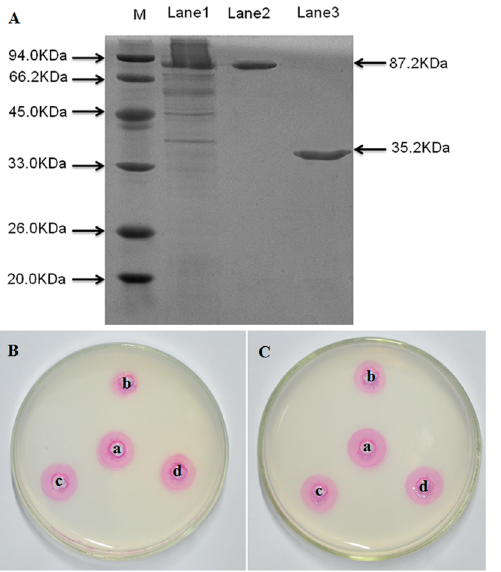
Fig 5. Purification and characterization of recombinant CkPGIP1. A. Lane 1, total protein extract from E . coli expressing recombinant CkPGIP1; Lane 2, flow through from a Ni-IDA superflow column; Lane 3, purified CkPGIP1, with fusion tags removed. B-C. Agarose diffusion assay of Botrytis cinerea ( B ) and Rhizoctonia solani polygalacturonase ( C ) in the presence or absence of purified recombinant CkPGIP1. a, 25 μ L enzyme; b, 25 μ L enzyme + 15 μ g CkPGIP1; c, 25 μ L enzyme + 25 μ L phosphate-buffered saline; d, 25 μ L enzyme + 15 μ g heat-denatured CkPGIP1. Inhibitory activity is inversely proportional to the size of the ring, and the present of inhibition is indicated by a smaller ring size between comparisons.